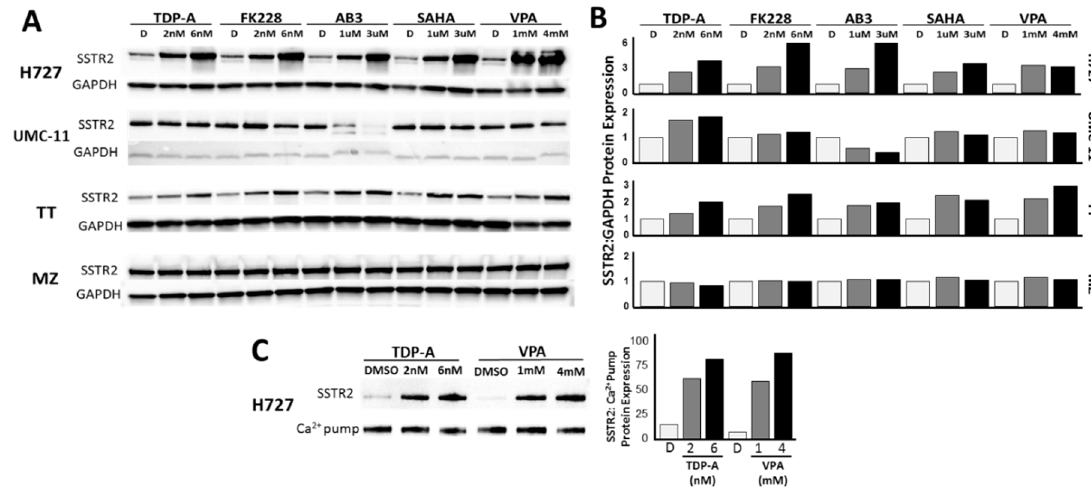
Figure 3. Increase in SSTR2 protein expression. ( A ) Upregulation of SSTR2 expression in NET cell lines by HDAC inhibitor treatment. The pulmonary carcinoid cell line, H727, showed the highest fold induction of SSTR2 (Supplementary Figure S3). ( B ) Ratio of SSTR2 protein expression relative to GADPH protein expression in NET cell lines after incubation with HDAC inhibitors ( C ) Upregulation of SSTR2 expression in the cell surface proteins of pulmonary carcinoid cell line H727 after TDP-A and VPA administration (Supplementary Figure S4).